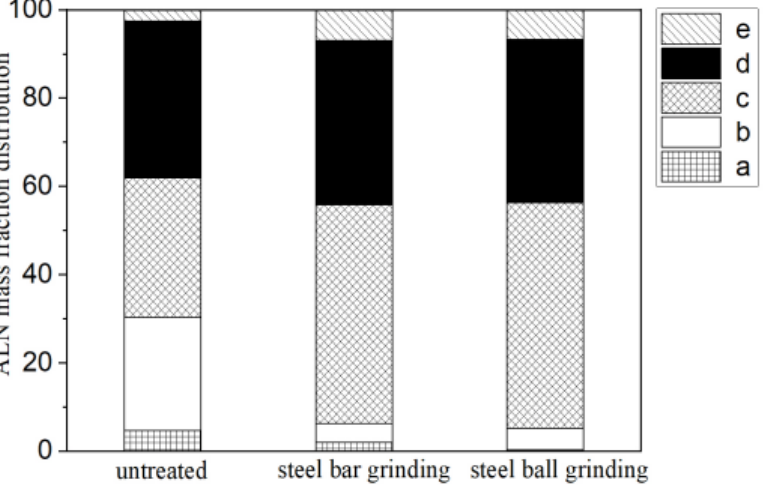
Figure 4. AlN mass fractions of different particle sizes of AD after ball milling or without treatment (a: >2 mm, b: 0.425–2 mm, c: 0.15–0.425 mm, d: 0.08–0.15 mm, e:<0.08 mm).